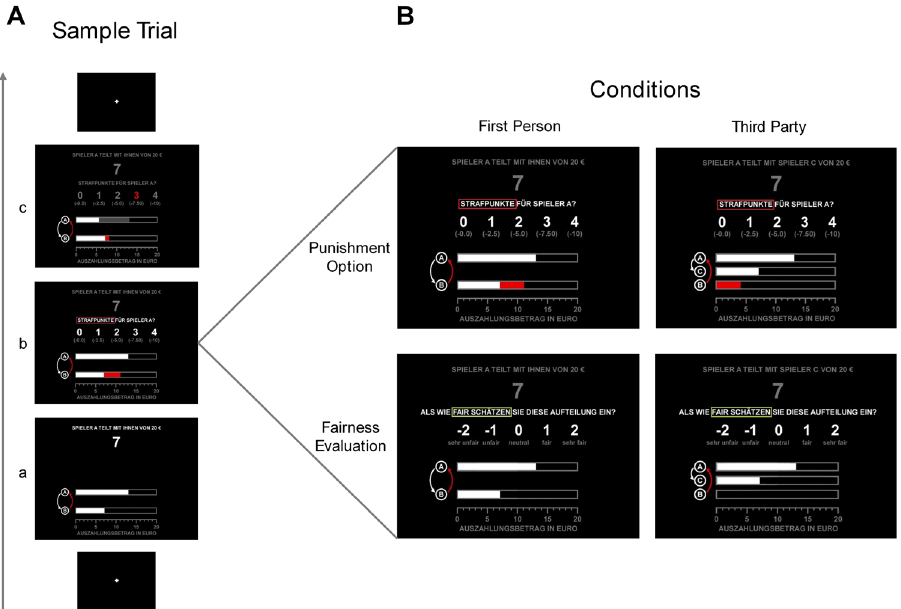
Figure 2. Summary of the paradigm. ( A ) Dictator Game sample trial (13:7 assignment) with punishment option in the first person condition. After viewing a fixation cross for 2,250 ms (variable duration, range 2,000– 2,500 ms), (a) participants saw a specific dictator assignment for 2,000 ms (in this example 7 €). (b) Thereafter, participants had the option to punish the dictator for this assignment by allocating 0 to 4 punishment points (maximal decision time 5,000 ms). (c) After the decision, participants saw a feedback screen presenting the trial-specific outcomes for all involved parties (2,000 ms + (5,000 ms–decision time)). ( B ) Overview over the conditions used in this experiment: First person perspective/punishment option, first person perspective/ fairness evaluation, third party perspective/punishment option, third party perspective/fairness